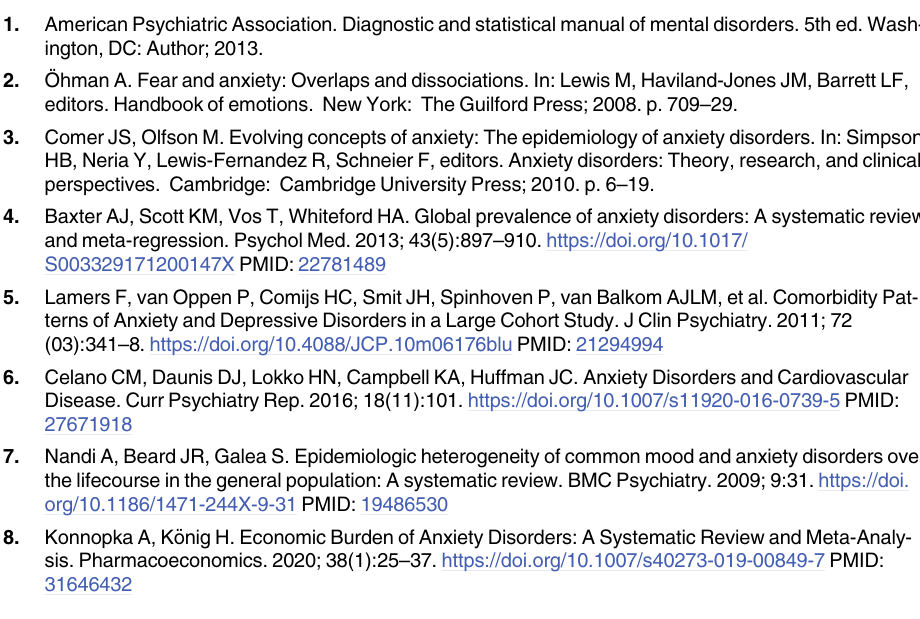
S8 Table. ANOVA’s results regarding the self-report measures, considering trait-somatic anxiety